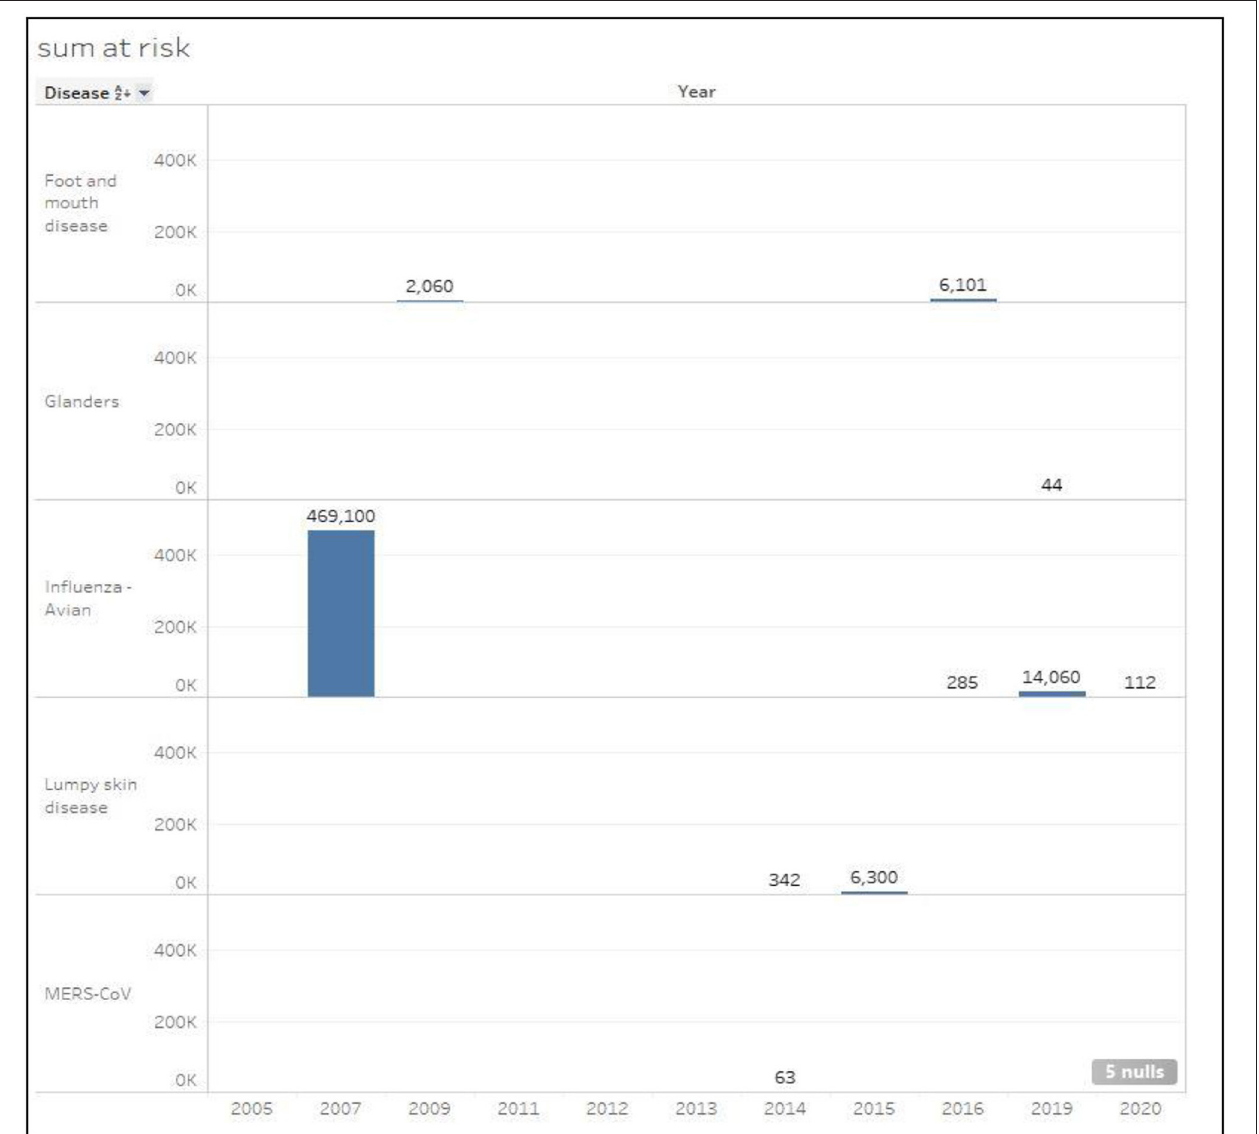
FIGURE 5 | Total number of susceptible cases classified by disease in Kuwait during the period